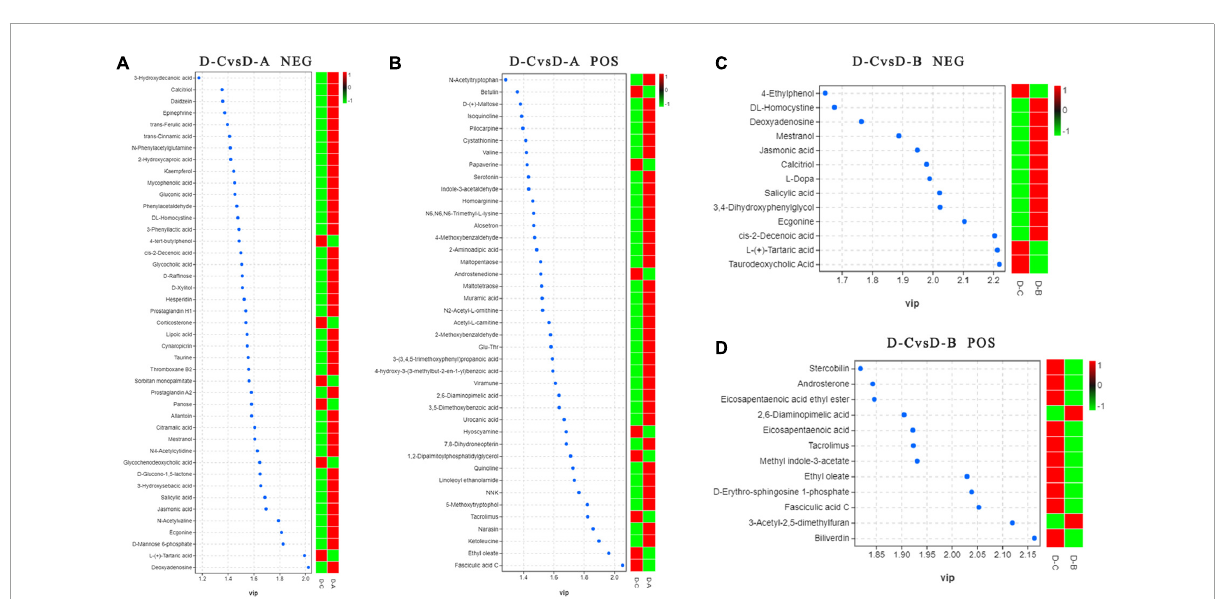
FIGURE6 Distinguishing metabolites in the rumen fluid. (A) Differential metabolites between D-C and D-A in the neg mode, (B) differential metabolites between D-C and D-A in the pos mode, (C) differential metabolites between D-C and D-B in the neg mode, and (D) differential metabolites between D-C and D-B in the pos mode. VIP > 1, P <